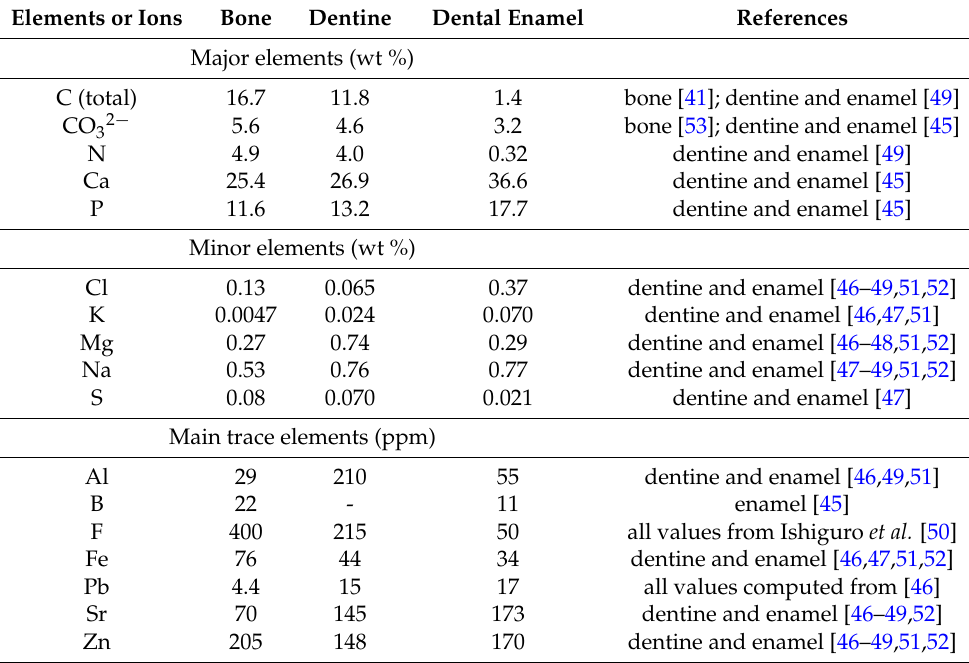
Table 1. Mean values of elemental composition of dried human main hard tissues (determined